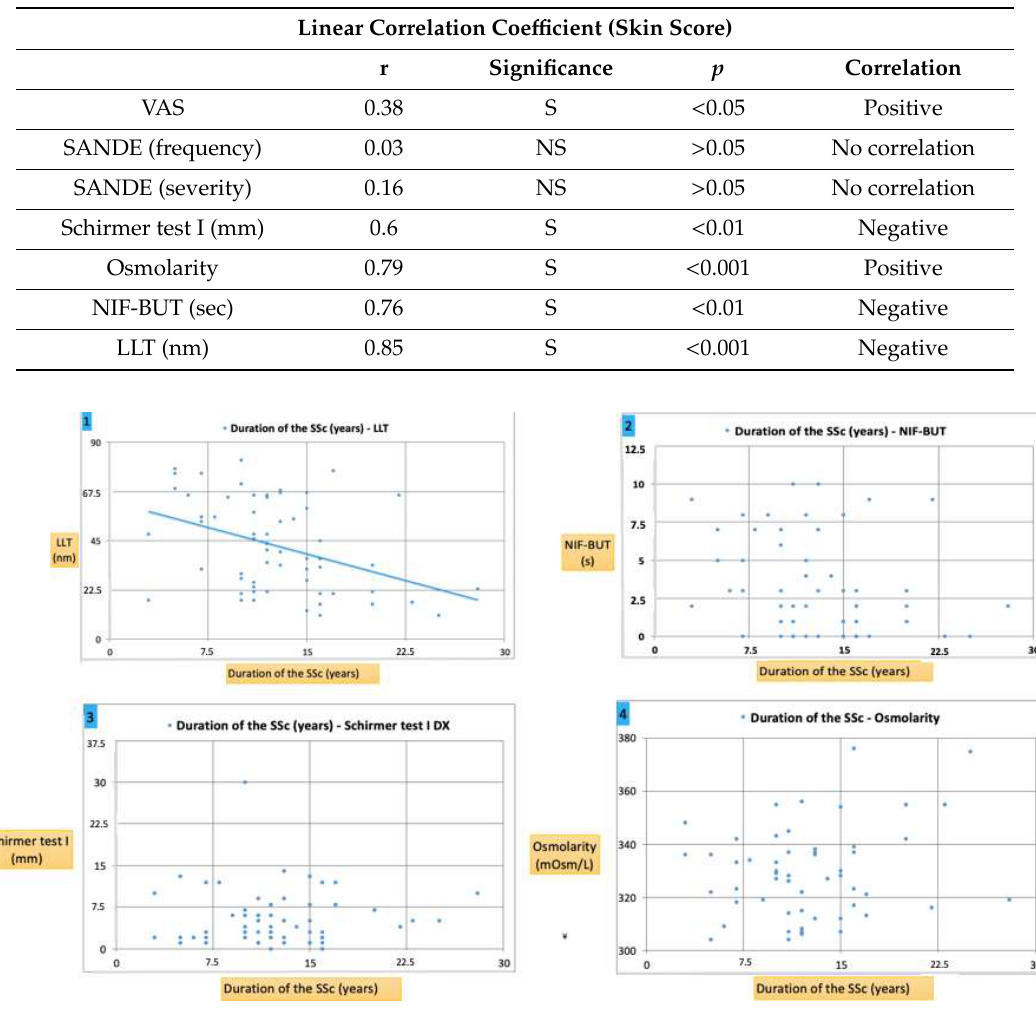
Figure 7. Graph 1: a negative correlation was found between the LLT (nm) and the duration of SSc ( p < 0.05), showing a marked decrease in patients with a longer duration of SSc. Graph 2 and Graph 3: no correlation was found between the NIF-BUT (s), Schirmer test I (mm) and the duration of SSc ( p > 0.05, both cases). Graph 4: a positive correlation was found between the osmolarity (mOsmol / L) and the duration of SSc (r = 0.2; p > 0.05), showing an increase in patients with a longer duration of